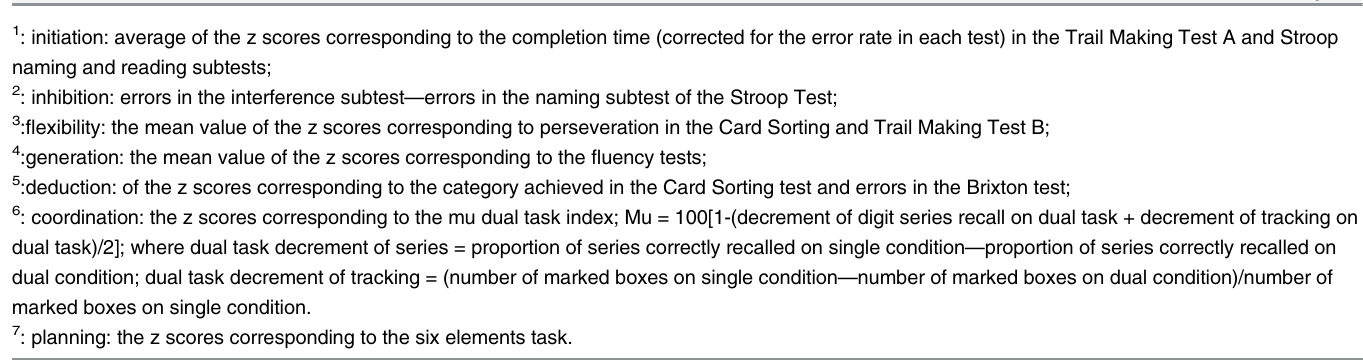
(regression 1: presence of behavioral dysexecutive syndrome, regression 2: presence of cogni- tive dysexecutive syndrome) and the stroke subtype as independent variable (infarct, hemor- rhage, ACoA, CVT).